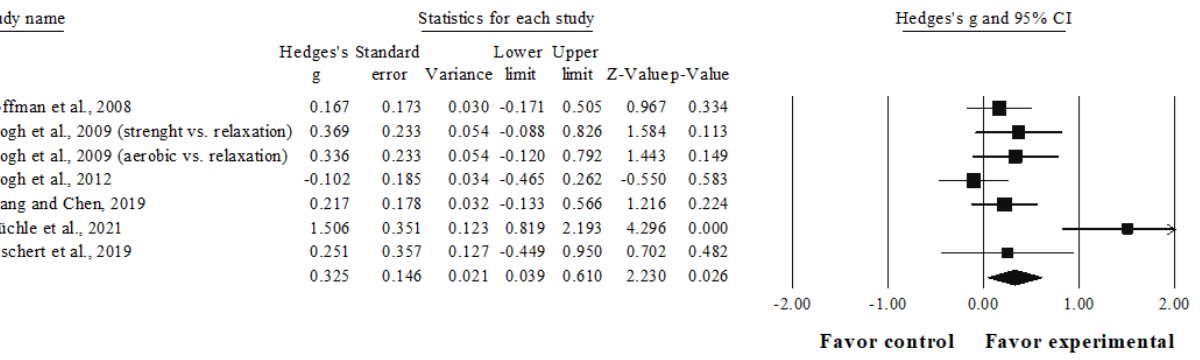
Figure 2. Forest plot for working memory outcome. Values shown are effect sizes (Hedges’s g) with 95% confidence intervals. The size of the plotted squares reflects the statistical weight of the study. Black squares: individual studies. Black rhomboid: summary result.